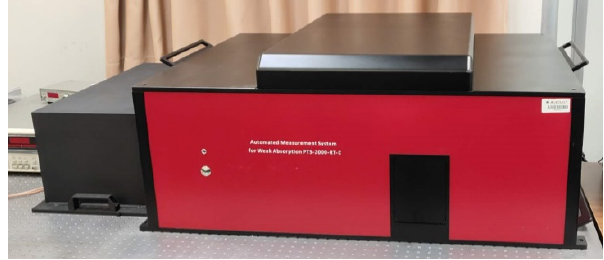
Figure 11. Photothermal weak absorption test platform.